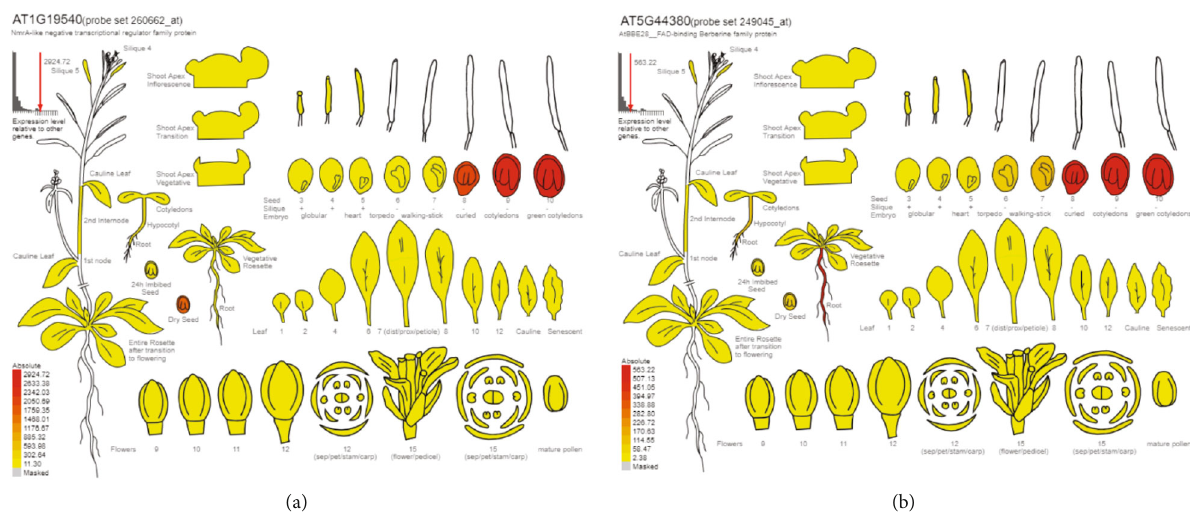
Figure 6: Expression patterns of two hub genes, AT1G19540 (a) and AT5G44380 (b), when viewed through the Arabidopsis eFP browser. The normalized expression value for each gene is colour-coded as indicated by the legend.